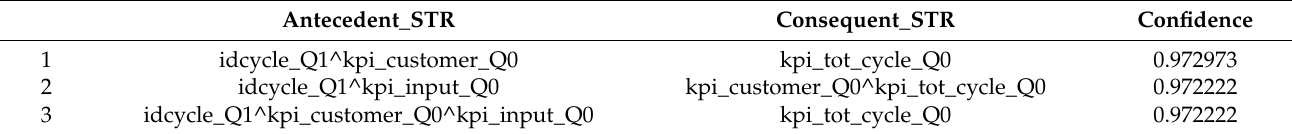
Table 5. Rules explaining the lower quartile values for the kpi_tot_cycle .